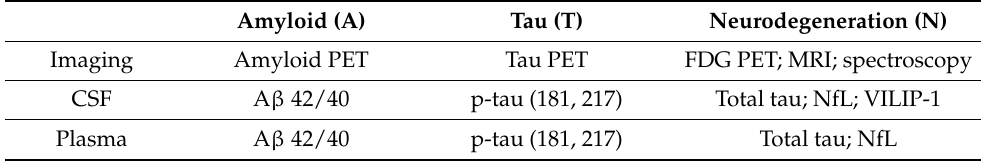
Table 3. Amyloid, tau, neurodegeneration (AT(N))